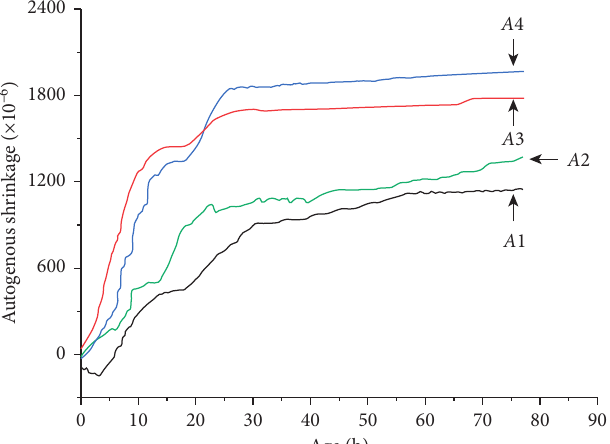
Figure 5: Effects of LC on the autogenous shrinkage of UHPC ( A 1 � 0% LC; A 2 � 0.075% LC; A 3 � 0.1% LC; A 4 � 0.125% LC; h � hour).